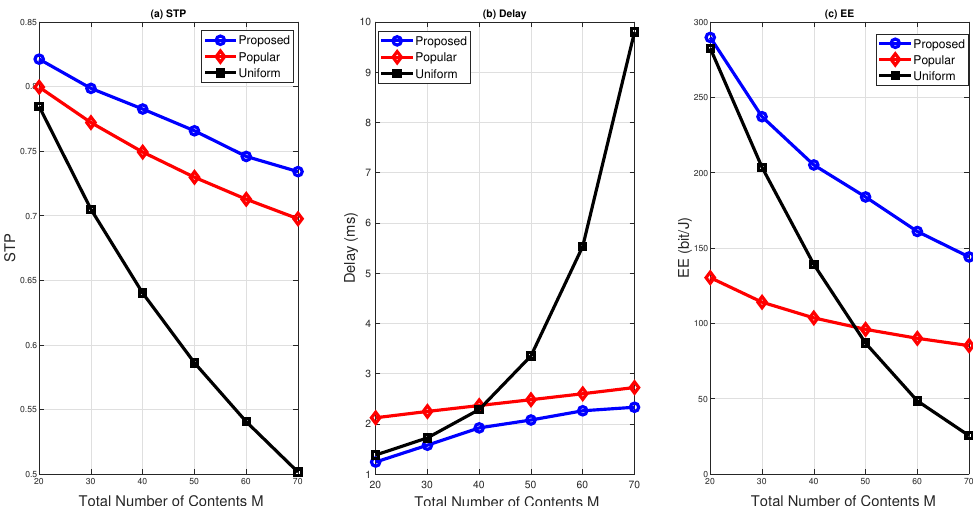
Figure 4. STP, delay, and EE versus total number of contents when λ U = 0.1 users/m 2 , λ F = 0.01 F-APs/m 2 , λ C = 0.0001 C-APs/m 2 , R = 150 m, γ = 0.8, α = 4, P F = 30 dBm, P C = 40 dBm, P s = 37 dBm, ρ = 15.13, W F = 100 MHz, W C = 500 MHz, T = 1 ms, and τ = 0.01 Mbps.